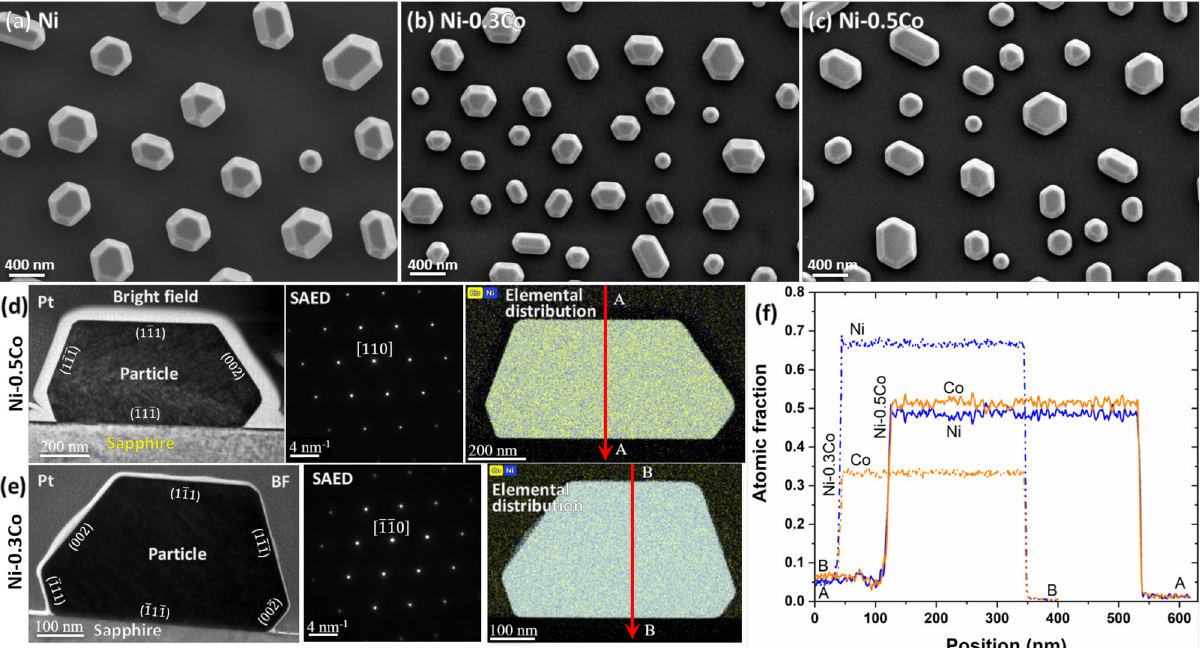
Fig. 2 Characterization of Ni and Ni-Co nanoparticles produced by solid-state dewetting. SEM micrographs of faceted single-crystalline ( a ) Ni, ( b ) Ni- 0.3Co, and ( c ) Ni-0.5Co nanoparticles obtained by solid-state dewetting. d , e Bright- fi eld TEM micrographs, selected-area electron diffraction (SAED) patterns, and TEM EDS elemental distribution maps (Blue: Ni; Yellow: Co) for ( d ) Ni-0.3Co and ( e ) Ni-0.5Co nanoparticles. f Concentration line pro fi les across the particles along the lines AA and BB marked in ( d ) and ( e ).